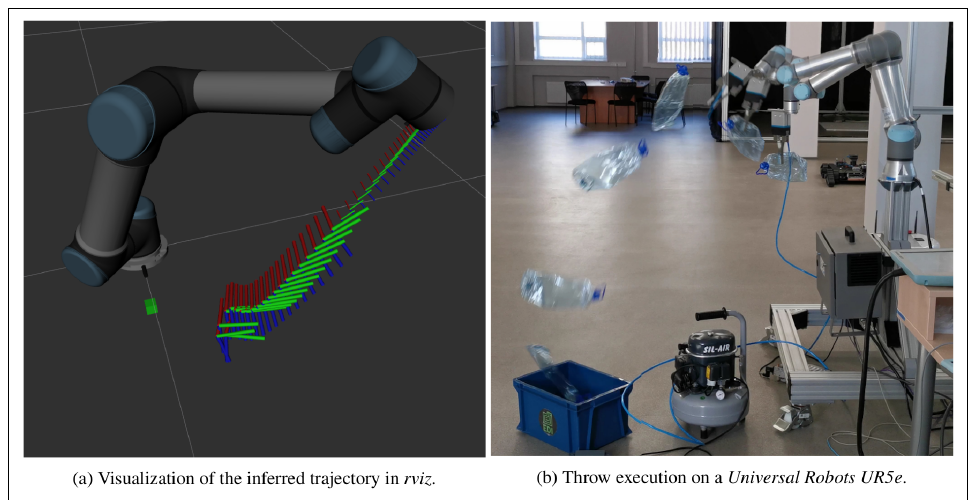
Figure 5. Qualitative performance evaluation—visualization and execution. In both cases, the trajec- tories were sequences of pose (position, orientation) goals obtained by running the models autore- gressively on their outputs at prior time steps. Release timing is represented in ( a ) by the change in marker